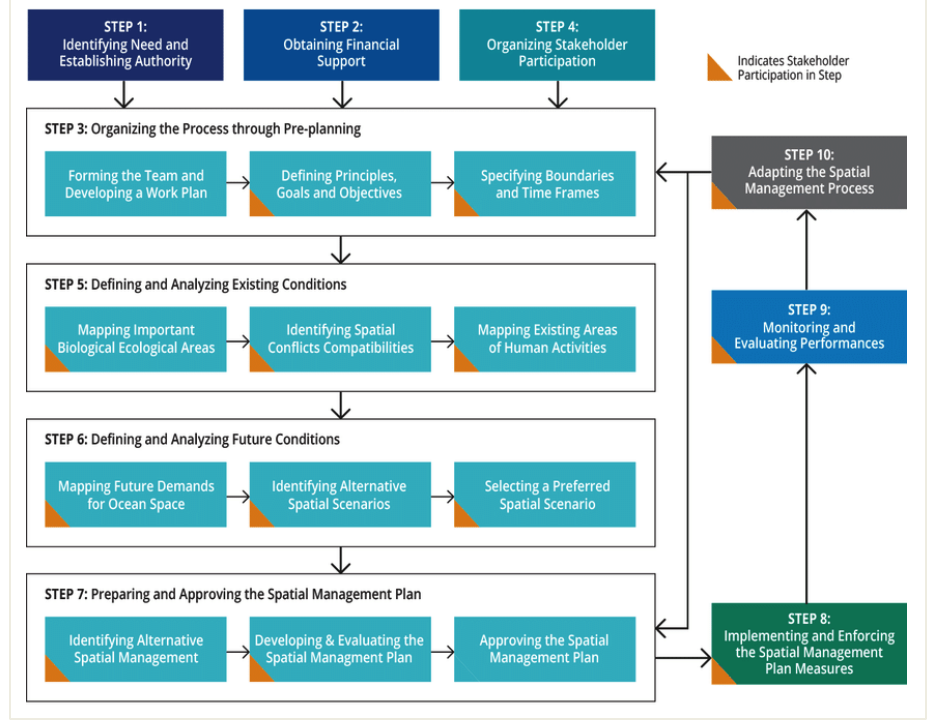
Figure 9. MSP step-by-step guide. Reprinted with permission from Ref. [37], Copyright 2006 UNESCO.